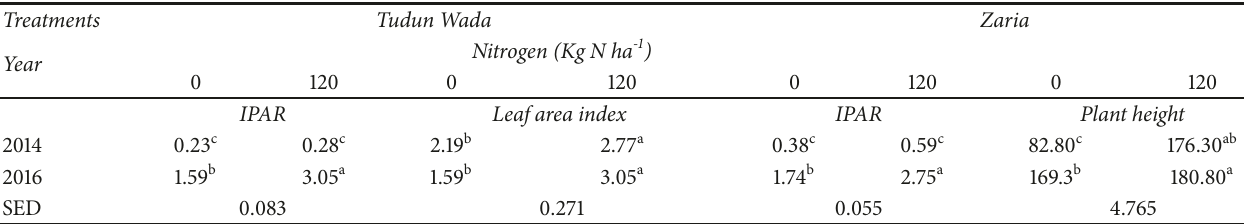
Means followed by the same letter(s) within rows and columns are not significantly different using DMRT. SED = standard error of a